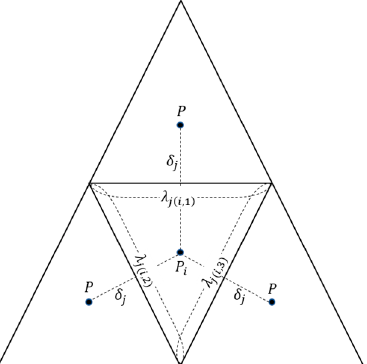
Figure 1. Orthogonal unstructured mesh and its notation used in the General Ocean Model (GOM), where P i is the i th polygon; λ j ( i ,1 ∼ l ) is the length of the j th side when calling from the i th polygon; and δ j is the distance between the centers of neighboring cells that share the j th